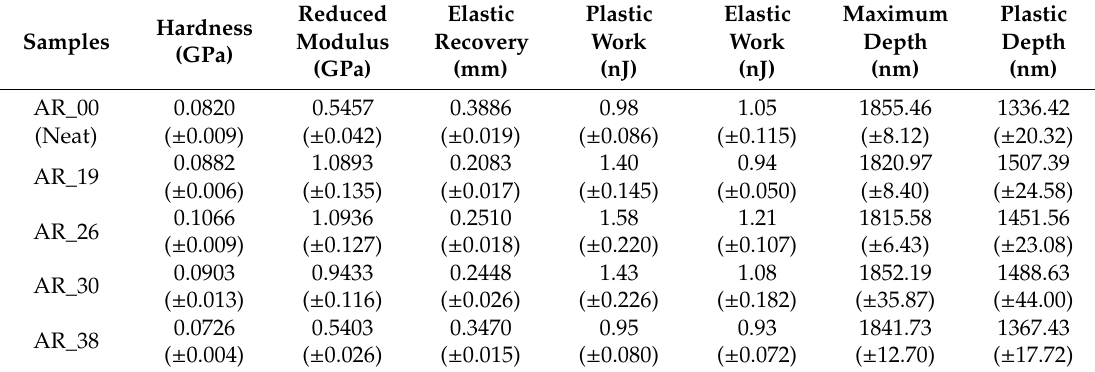
Table1. Nano-mechanicalpropertiesofthesamplesafternano-indentationtest, withstandarddeviation.